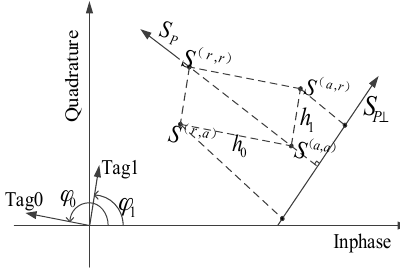
Figure 1. Mapping two collided tag signals to an IQ plane under a single receiving antenna.